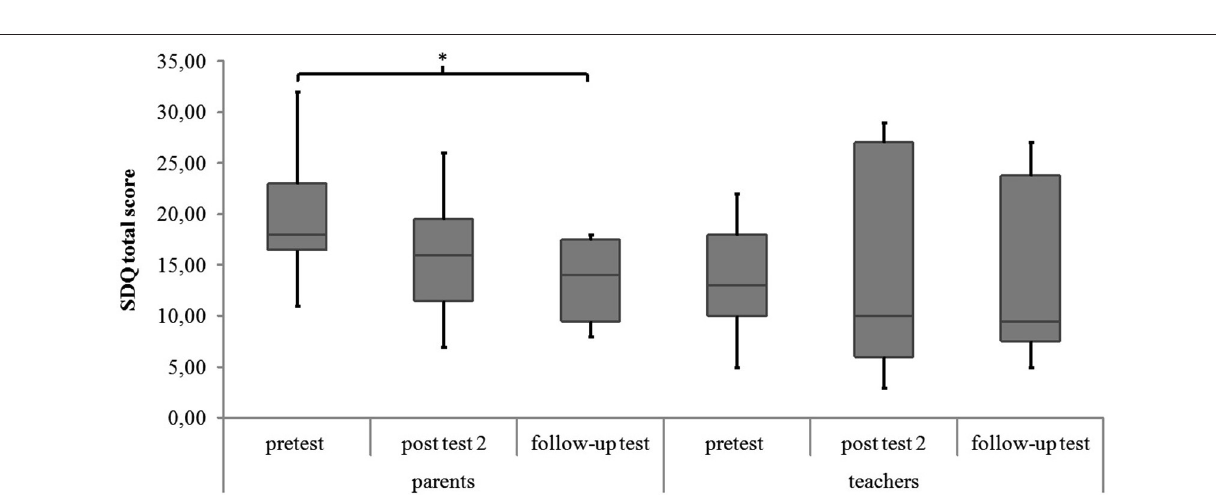
FIGURE 3 | FBB-ADHS total score of parents’ and teachers’ ratings for all meeasurement points . Middle line of boxes = median, box = interquartile range, error bars = minimum respectively maximum, * = significant.